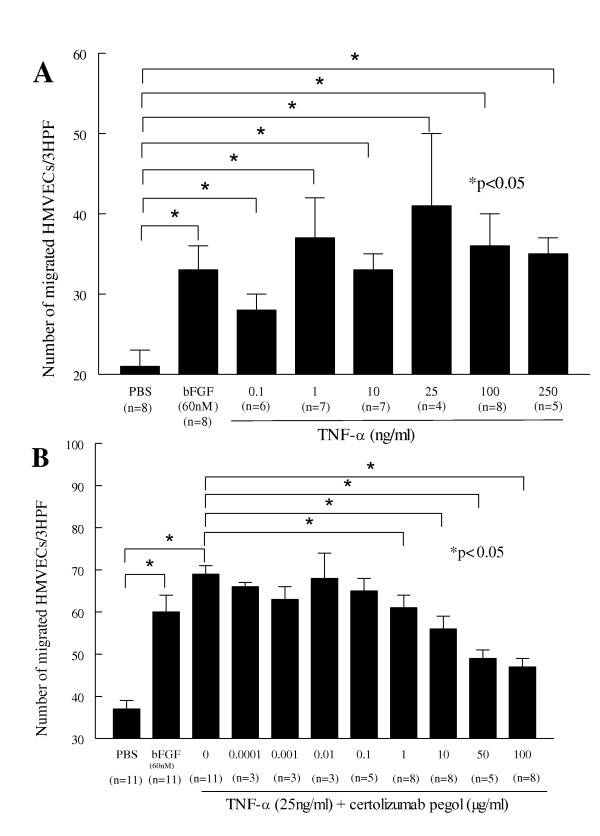
Certolizumab pegol inhibits TNFα-induced human dermal microvascular endothelial cell chemotaxis. (A) Increasing concentrations of TNFα induce human dermal microvascular endothelial cell (HMVEC) migration, which is significant from concentrations of 0.1 to 250 ng/ml, compared with PBS control (*P < 0.05). (B) Certolizumab pegol (1 to 100 μg/ml) decreased TNFα-induced HMVEC migration (from 69% to 89%) when HMVECs were preincubated with different concentrations of certolizumab pegol (*P < 0.05). Cell migration per three high-power fields (3HPF; ×400) was determined by the number of HMVECs migrated towards an angiogenic stimulus. Results represent the mean number of migrating cells per each quadruplicate well ± standard error of the mean. n, number of individual experiments. The positive control was basic fibroblast growth factor (bFGF; 60 nM) and PBS was the negative control.